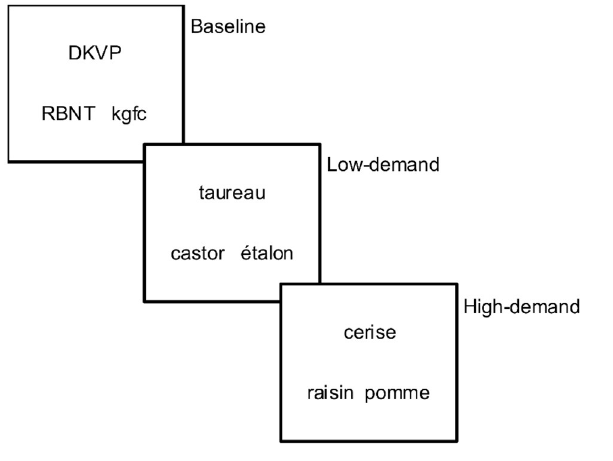
Fig 5. Examples of